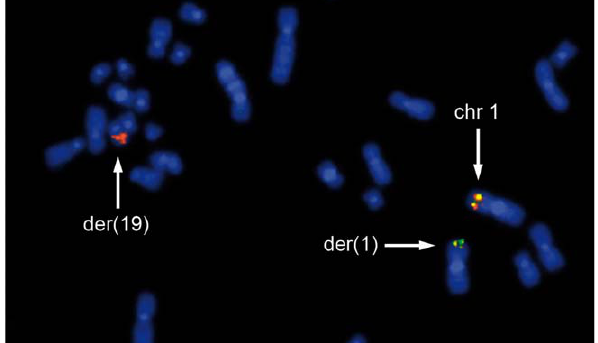
Figure 6. Delineation of PUM1 breakpoint by metaphase FISH. Part of metaphase of cell line S40.2 after FISH with two overlapping BAC clones RP11-201O14 (green) and RP11-1136E4 (red) both spanning the whole genomic sequence of PUM1 in 1p35.2. The breakpoint in 1p35.2 is located within PUM1 indicated by a separation of RP11-201O14 and RP11-1136E4. Because of weak signals of RP11-1136E4 remaining on the der(1) the breakpoint is located within RP11-1136E4 distal to RP11-201O14.